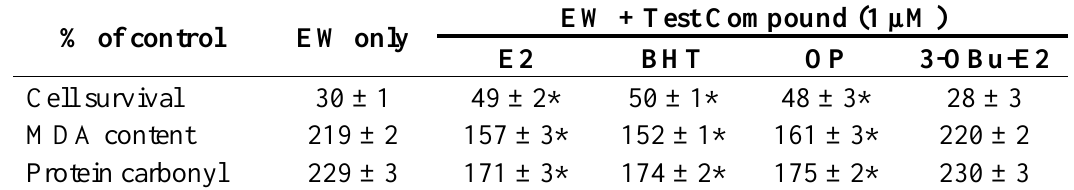
Table 1. The comparison between protective effects of phenolic and non-phenolic test compounds. HT-22 cells were exposed to 24- hour-ethanol (200 mM) followed by 4-hours- ethanol withdrawal (EW) with or without (EW only) concomitant treatment with phenolic test compounds (1µM, Figure 1 ) [ 15 , 64] . In control experiments (vehicle only, no ethanol), cell viability was counted as 100%, MDA level was 173 – 6.5 nmol/mg (cid:215) protein and protein carbonyl content was 1.28 – 0.01 nmol/mg (cid:215) protein.* p < 0.01 vs. corresponding EW only (no test